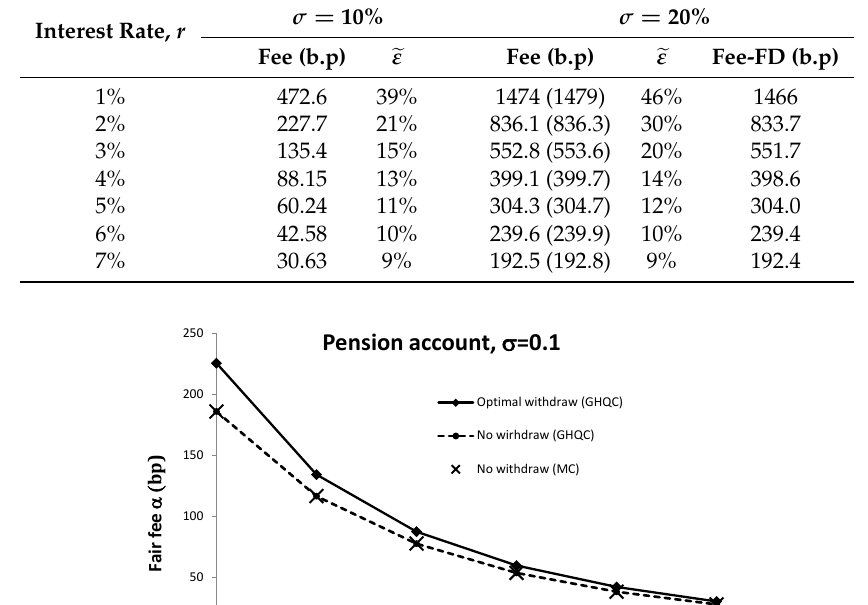
Table 4. Fair fee α in bp (1 bp = 0.01%) as a function of interest rate r for the GMAB for a pension account when withdrawals are optimal. The contract maturity is T = 10 years and quarterly withdrawal limit is G n = 0.25 × 15%. (cid:101) ε is the percentage difference between the fair fee in the case optimal withdrawal and the fair fee in the static case (no withdrawal) from Table 1. The numbers in the parentheses next to the continuous fair fee are the results for the quarterly charged fees.